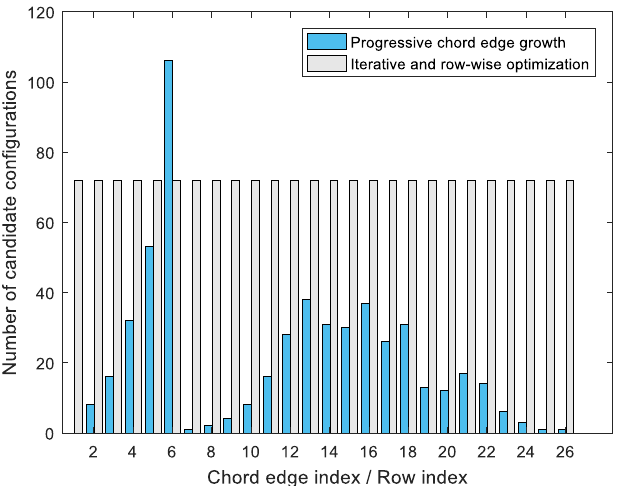
Figure 5. The number of candidate configurations for each chord